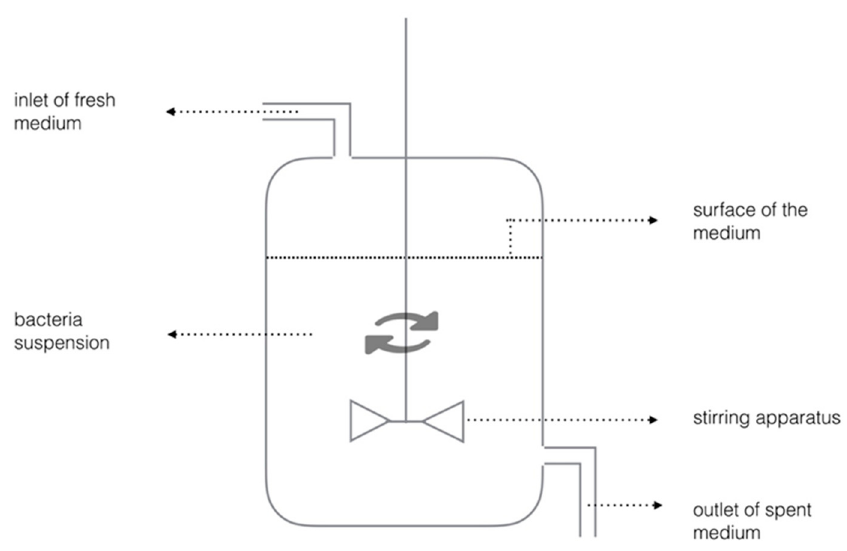
Figure 4. Schematic diagram of chemostat.